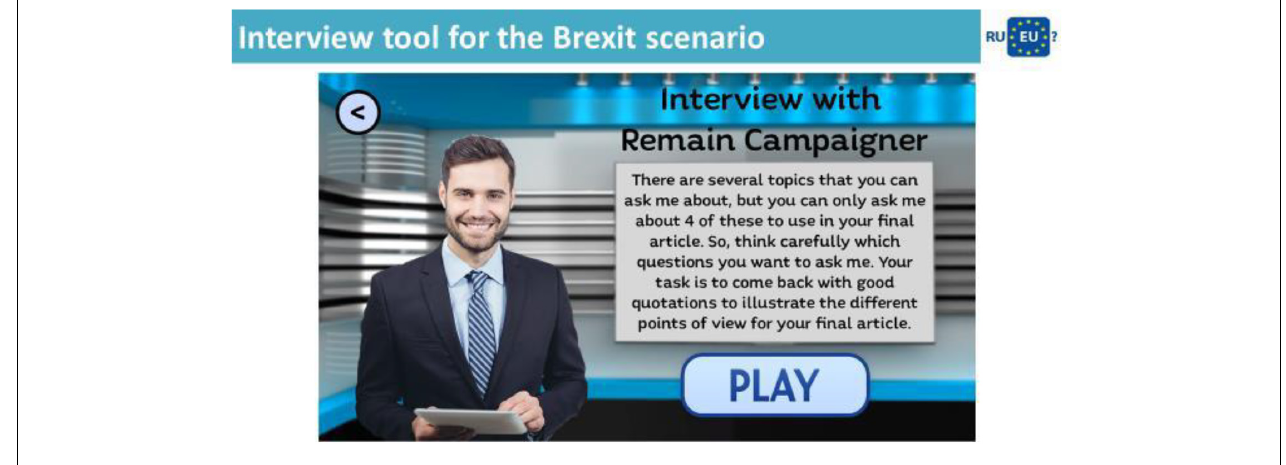
FIGURE 3 | A screenshot of the Interview tool with the Brexit scenario.